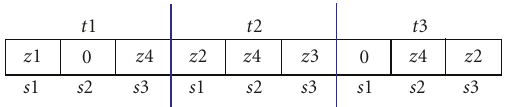
Figure 6: Example on the simulated annealing solution in which 4 zones are monitored by 3 sensors for 3 time